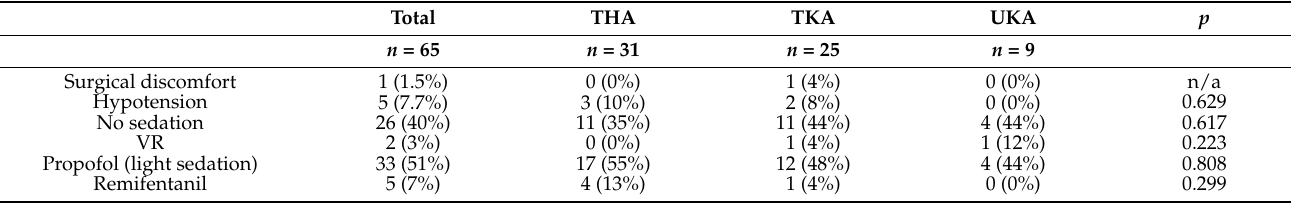
Table 2. Perioperative secondary outcomes.